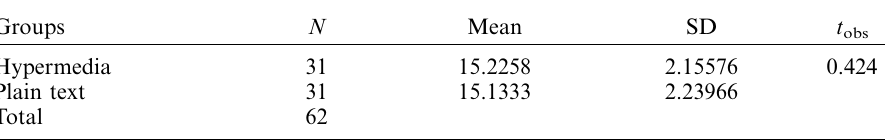
Table 6. Results of multidimensionality vocabulary knowledge.